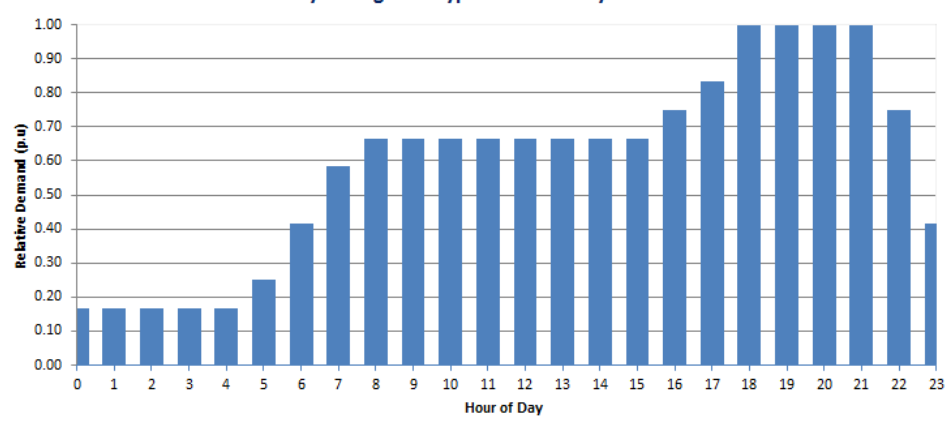
Figure 6. Hourly average relative demand for commercial load. Source [60].